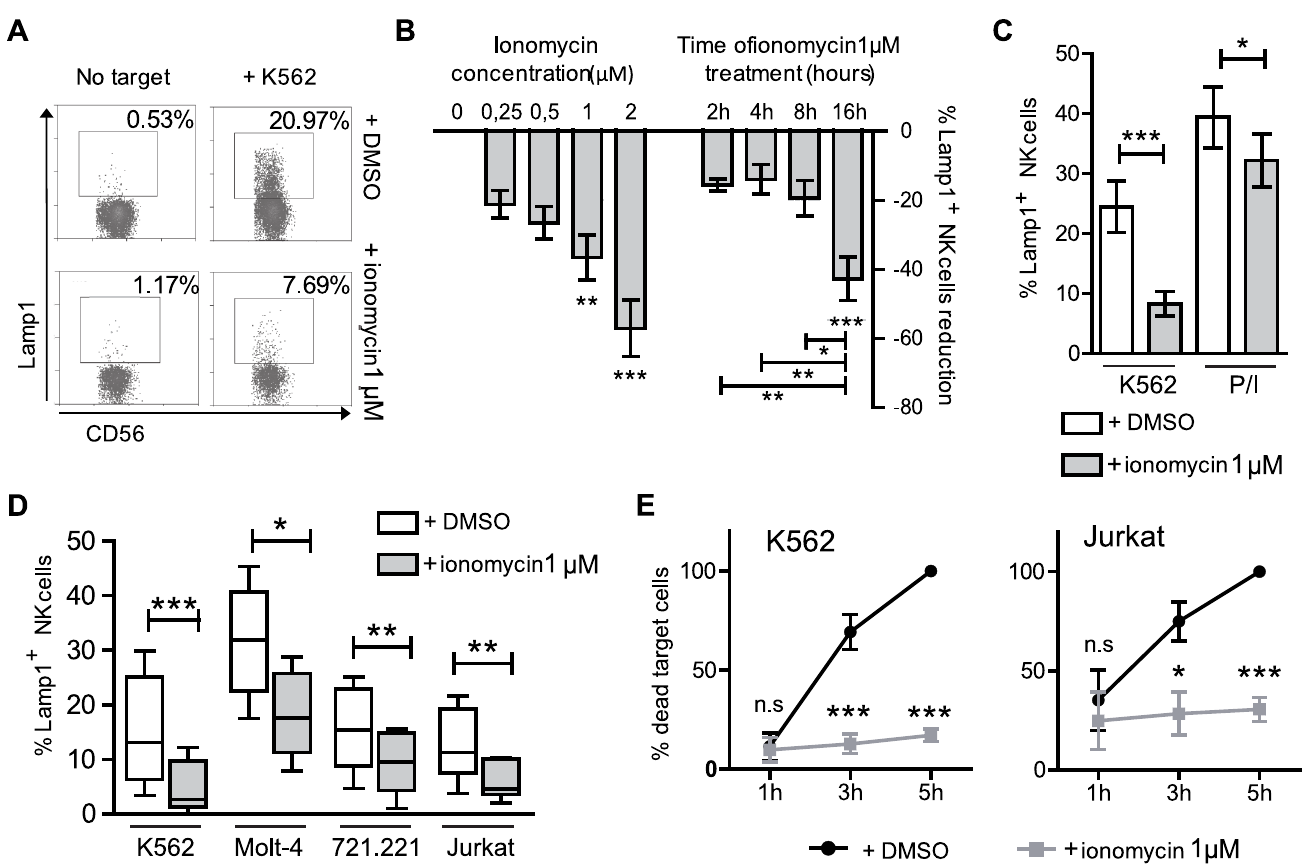
Fig 1. Ionomycin treatment reduces the degranulation and killing ability of NK cells. ( A ) Primary NK cells were treated with 1 μ M ionomycin, or DMSO as control, during 16 hours, and after resting for 24 h, their ability to degranulate in response to K562 cells (Lamp1 + NK cells) was analyzed. ( B ) The induction of NK cell unresponsiveness depends on the dose of ionomycin used (0.25 μ M to 2 μ M) in a 16 hours treatment, and the duration of the treatment (2 to 16 hours). Data represent the percentage reduction of Lamp1 + NK cells in ionomycin treated cells compared to control, DMSO exposed, cells. ( n = 5 ). One way ANOVA and Bonferroni post-test analysis were used to calculate statistical significance, using the logarithms of crude data. ( C ) Flow cytometry analysis shows that ionomycin-treated NK cells degranulate during 2 hours much more efficently in response to PMA/ionomycin rather than K562 cells ( n = 10 ). Two tailed paired Student's T test analysis. ( D ) Ionomycin-treated NK cells respond poorly to a range of different target cells during 2 hours ( n = 6 ). Two tailed paired Student's T test analysis. Whiskers show minimum to maximum data. ( E ) Reduced NK cytotoxicity measured by flow cytometry of ionomycin-treated NK cells ( n = 4 ). Two way paired ANOVA analysis and Bonferroni post-test. Data show mean ± SEM (with the exception of D), * p < 0.05, ** p < 0.01, *** p < 0.001.